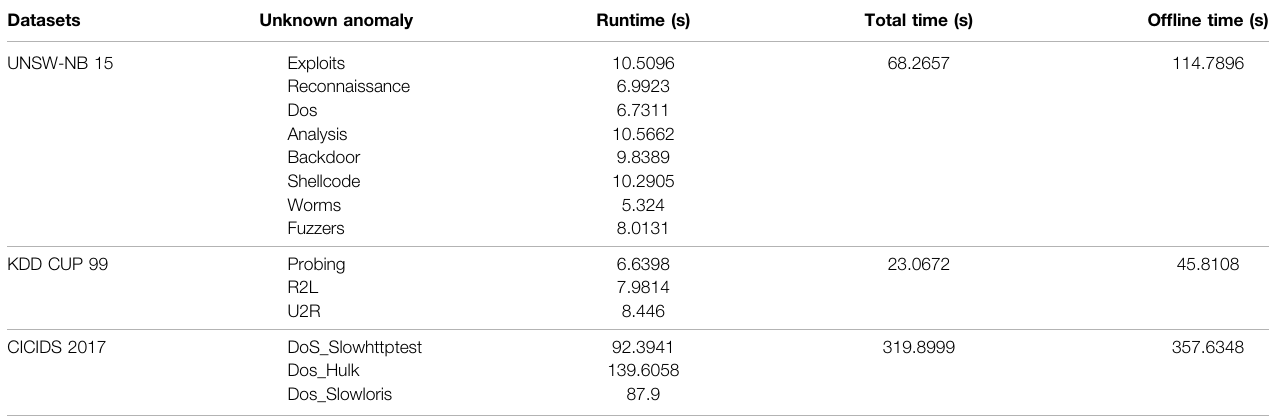
TABLE 3 | Runtime